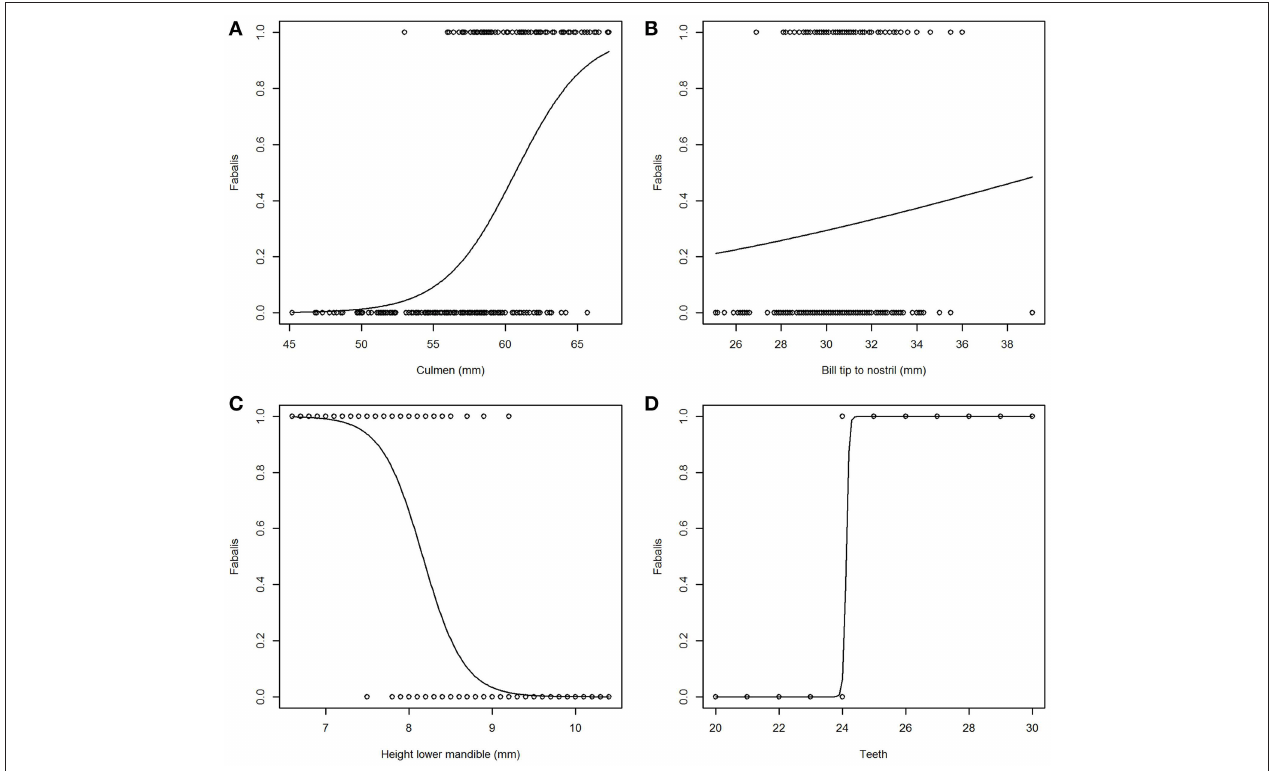
FIGURE 2 | Incidence plots from a selection of logistic models for subspecies ( rossicus = 0, fabalis = 1). Predicted responses go from poor in “Bill tip to nostril” (B) to distinct in “Teeth” (D) . Variables “Culmen” (A) and “Height lower nmandible” (C) show intermediate, contra-directional responses.